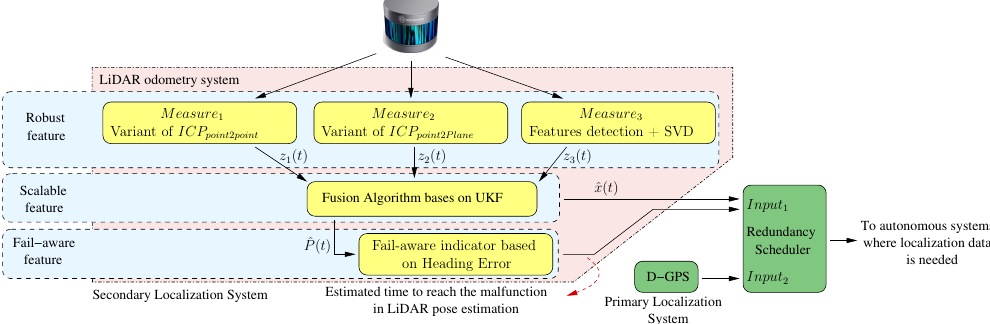
Figure 1. General diagram. The developed blocks are represented in yellow. The horizontal blue strips represent the main features of the odometry system. A framework where the LiDAR odometry system can be integrated within the autonomous driving cars topic is depicted with green blocks, such as a secondary localisation